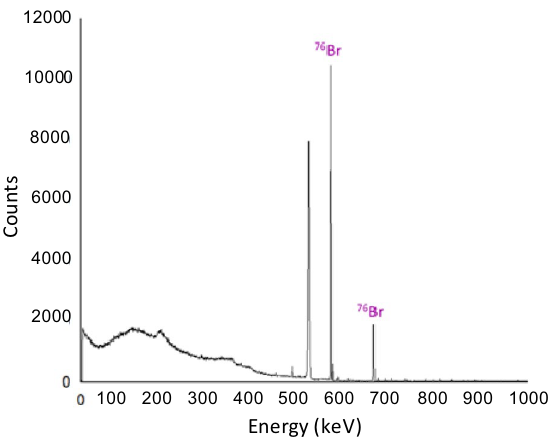
Figure 8. Gamma spectroscopy measurements (count time = 300 s) of stainless steel trap 3 after the transfer of krypton-76 gas to stainless steel trap 4. The successful movement of krypton gas due to changes in temperature is demonstrated by the lack of counts of activity of 76 Kr. The isolation of 76 Br is